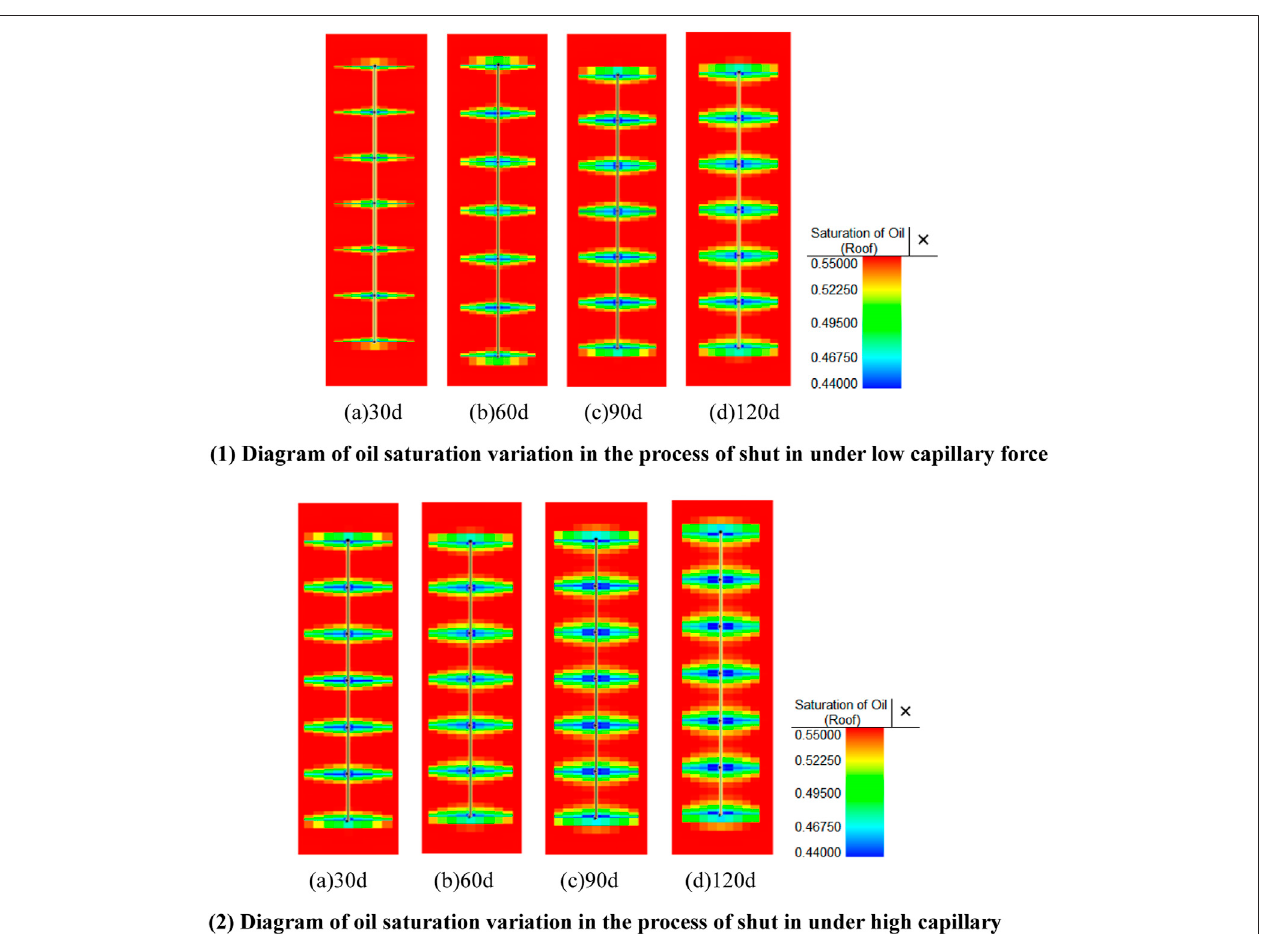
FIGURE8| Diagramofoil saturation variationintheprocess ofshutinunderdifferentcapillary. (A) Diagramofoil saturation variationintheprocess ofshutinunder lowcapillaryforce (i) 30d, (ii) 60d, (iii) 90d, (iv) 120d.( B )Diagramofoilsaturationvariationintheprocessofshutinunderhighcapillary (i) 30d, (ii) 60d, (iii) 90d, (iv) 120d.